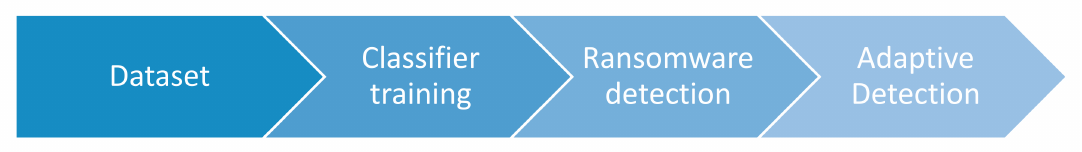
Figure 4. Significance of a dataset in a ransomware detection system development.